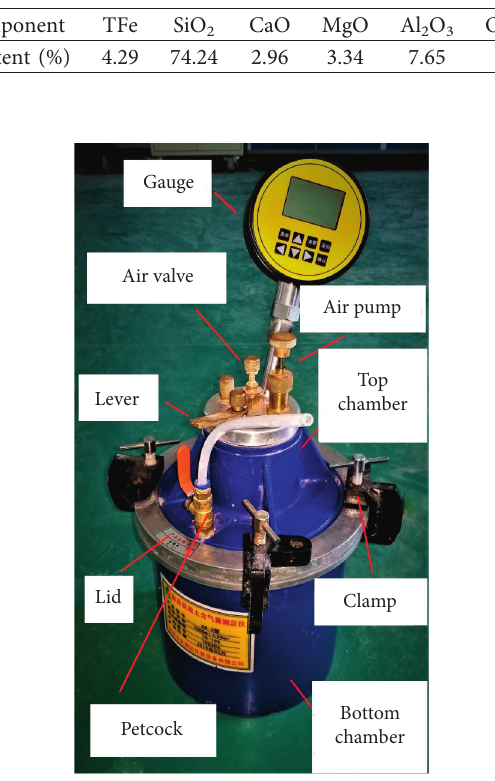
Figure 2: Air content tester for fresh